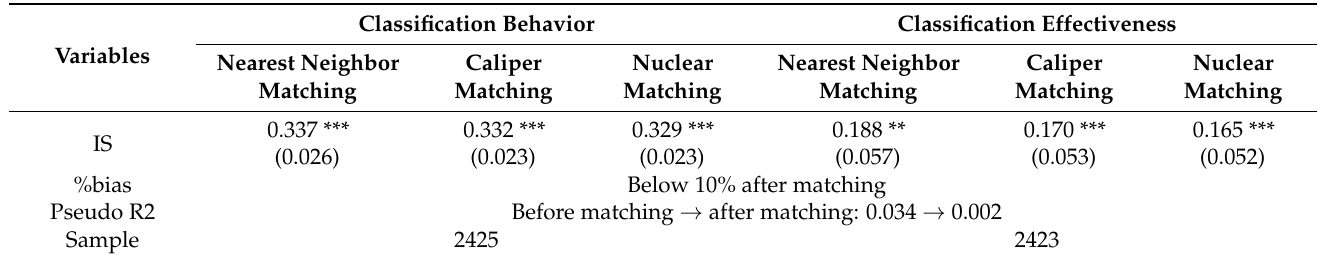
Table 9. Impact of policy support on the BWC and EWC: PSM